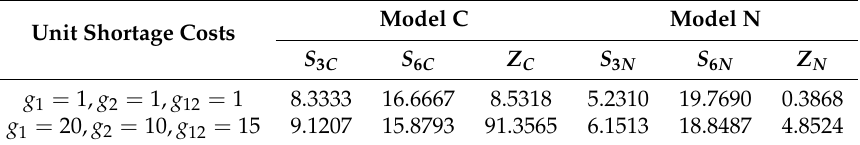
Table 2. Optimal allocations and optimal costs for each